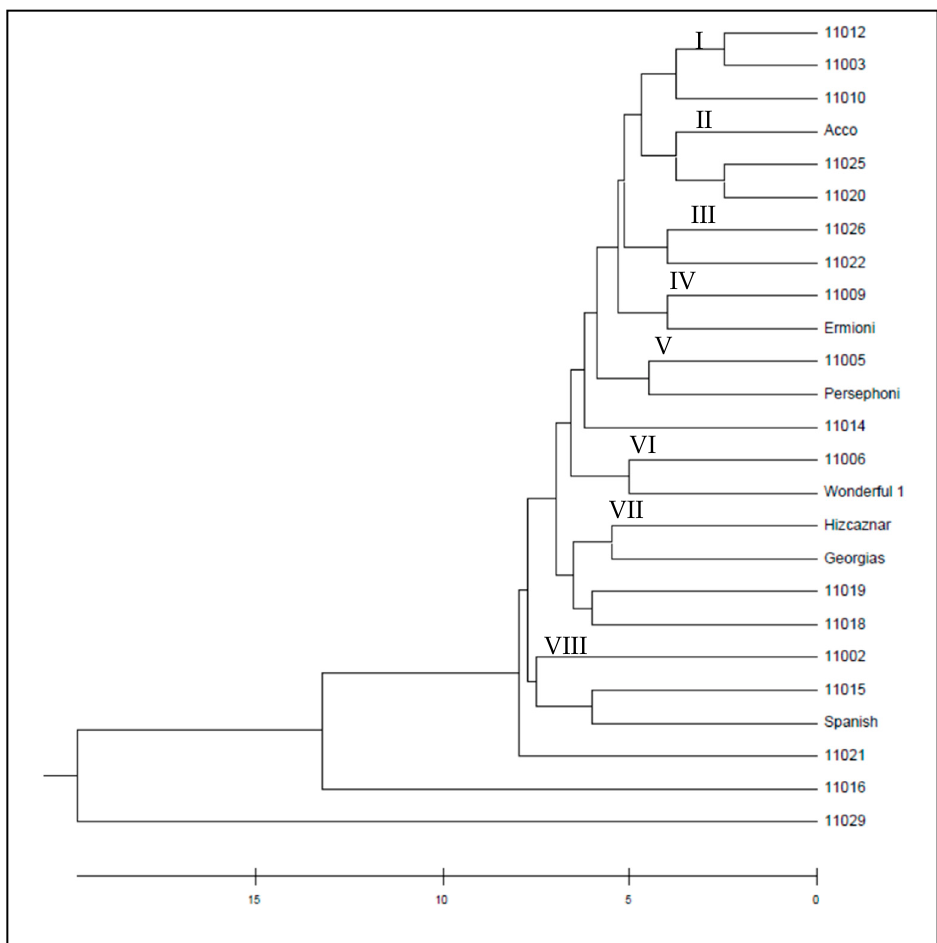
Figure 5. UPGMA dendrogram of the studied 26 pomegranate genotypes based on 11 SCoT mark- ers.